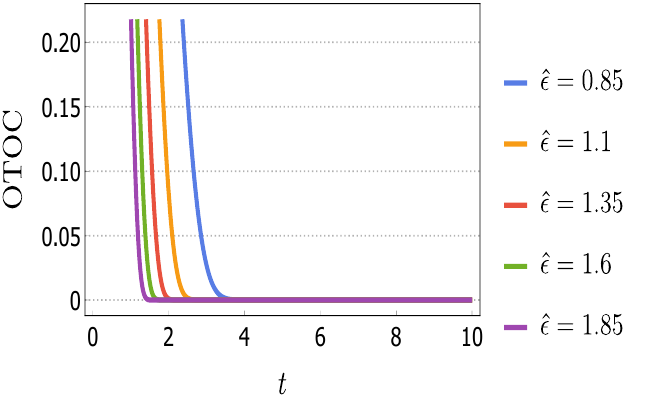
Figure 3 . Evolution of out-of-order correlator (OTOC) for a K = 2 parameter system with a variation of eigenvalue of Encoder-Dataset tensor A ∞